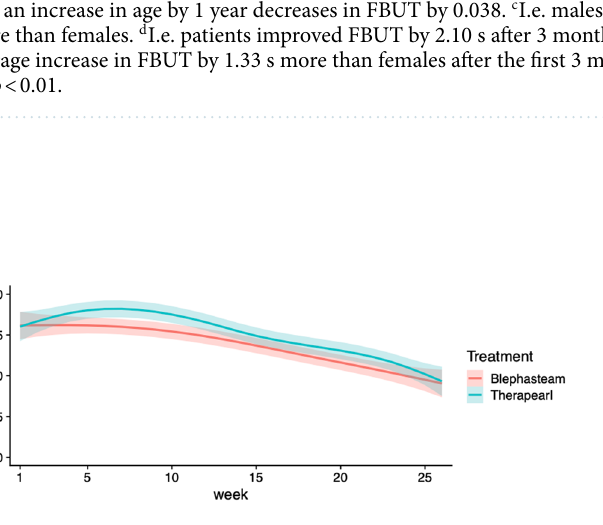
Figure 4. Compliance calculated as the average number of days per week that the patients were using the treatment. Smoothed conditional mean compliance were fitted using loess method for each treatment. 95% confidence bands were shown as shaded ribbon in respective colors. Figure created in R version 4.0 with ggplot2 package, version 3.3.5 (The R Foundation for Statistical Computing, Welthandelsplatz 1, 1020 Vienna,